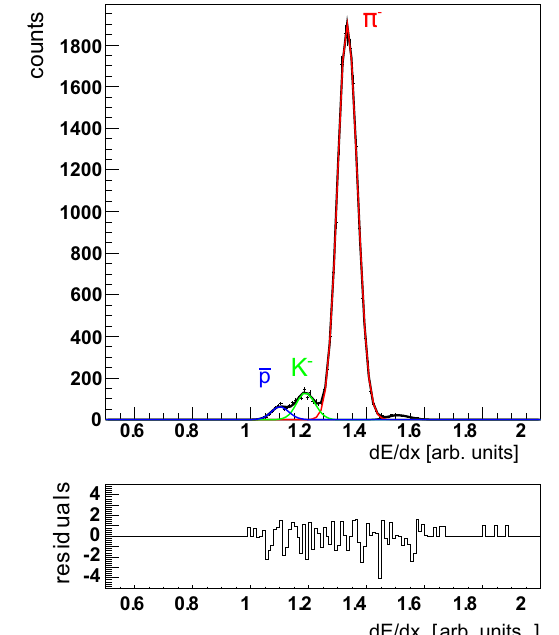
by solid lines. The corresponding residuals (the difference between the data and fit divided by the statistical uncertainty of the data) is shown in the bottom plots